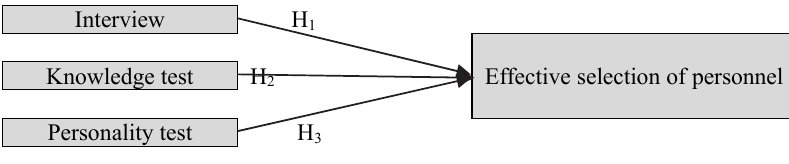
Fig. 1. Conceptual model and